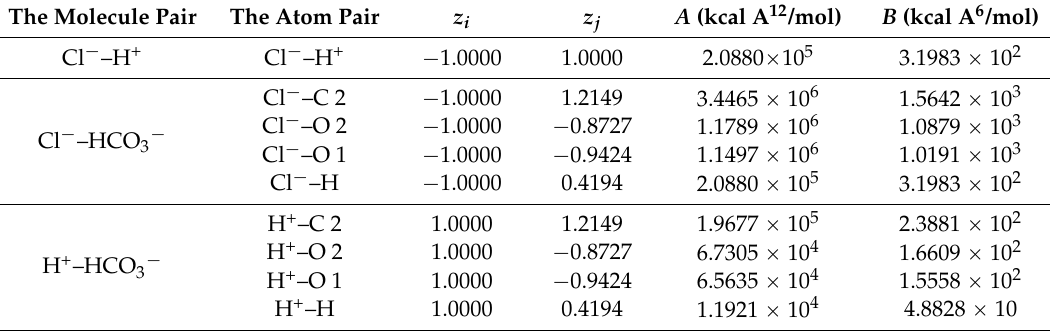
Table 11. The potential parameters between Cl ´ –H + , Cl ´ –HCO 3 ´ , and H + –HCO 3 ´